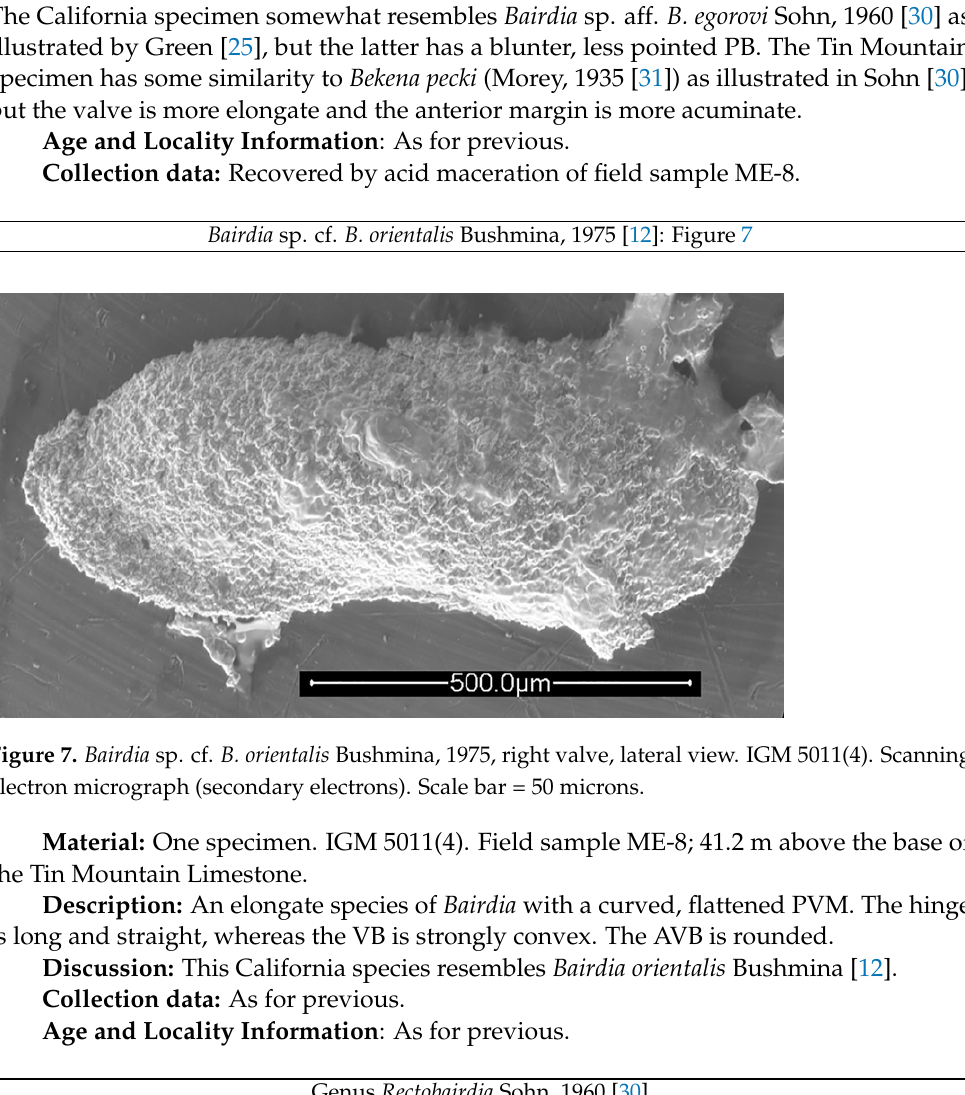
8 of 16 Figure 6. Bairdia quasilecta Bushmina, 1975, right valve, oblique lateral view. IGM 5011(3). Scanning